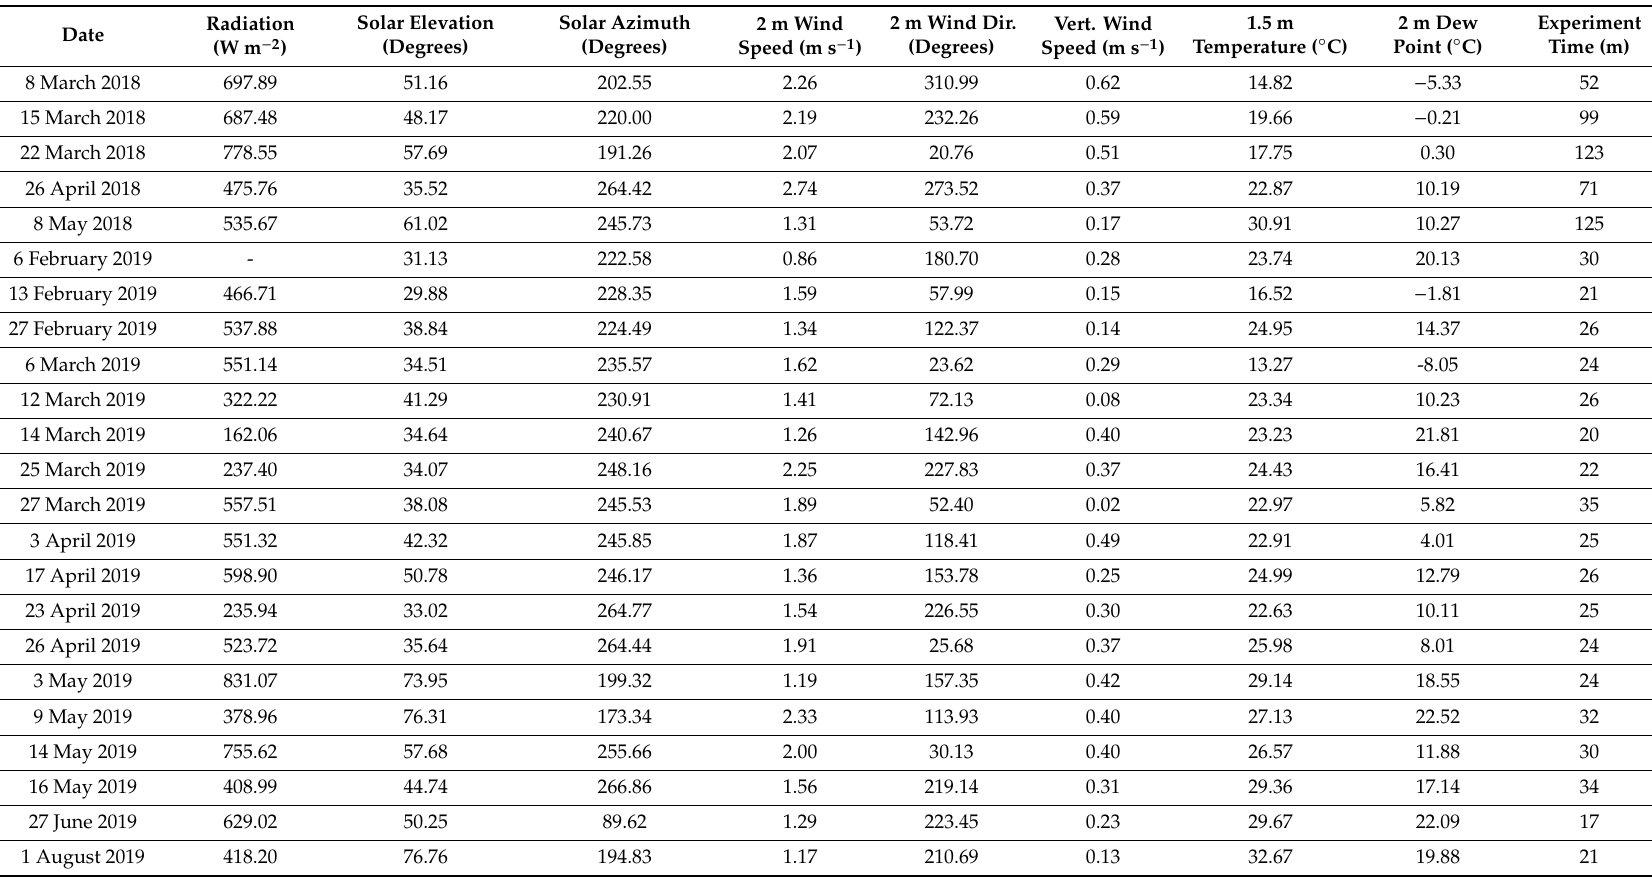
Table 2. Radiation Shield experiments by date with solar conditions, meteorological conditions, and experiment time averaged over the length of the experiment. Experiment duration, sample size (N), and missing values are also